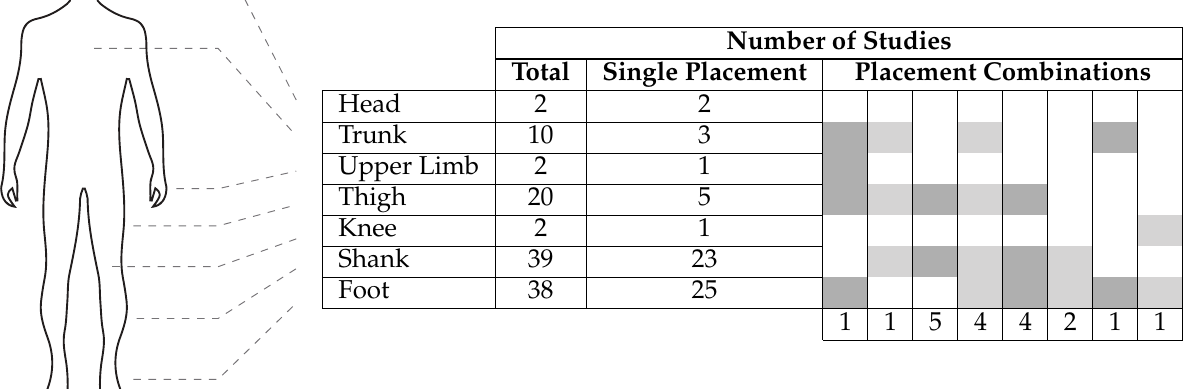
Figure 6. Number of studies using inertial measurement units (IMUs) that placed the sensor(s) on specific anatomical locations. Single placement contains studies where sensor(s) were placed only in one anatomical location. Placement combinations’ columns indicate studies where sensor(s) were placed in more than one location. Each relevant location is marked by a shaded cell and the number of studies using this combination is indicated at the bottom of the column. The total indicates the sum of studies where the sensor(s) were placed on that given anatomical